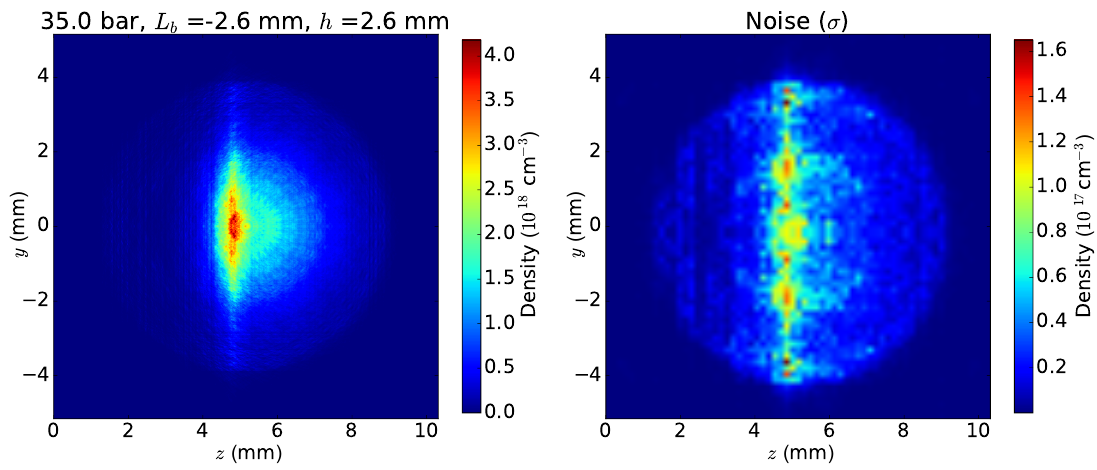
Figure 20. Error analysis of the reconstructed density (ML-EM, 15 iterations). Left : Reconstructed density distribution. Right : Noise of the